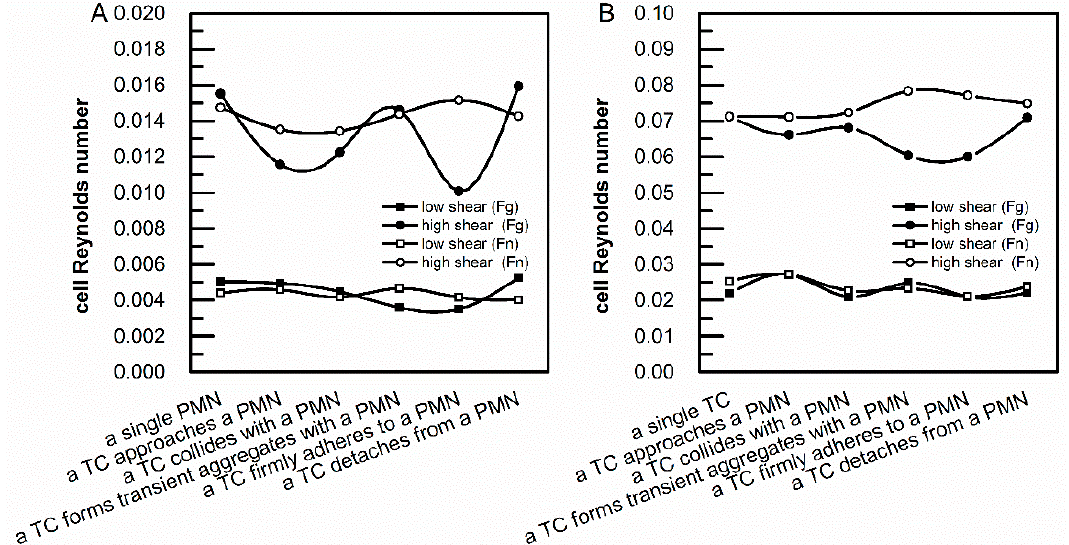
Figure 4. Cell Reynolds numbers of adherent cells in the presence of soluble fibrin (ogen). ( A ) Above an adherent PMN; ( B ) Above an adherent TC. Solid squares ( ■ ) represent a low shear condition (91.25 μ L min − 1 ) with sFg, solid circles ( ● ) represent a high shear condition (292 μ L min − 1 ) with sFg, open squares ( □ ) represent a low shear condition (91.25 μ L min − 1 ) with sFn, and open circles ( ○ ) represent a high shear condition (292 μ L min − 1 ) with sFn.